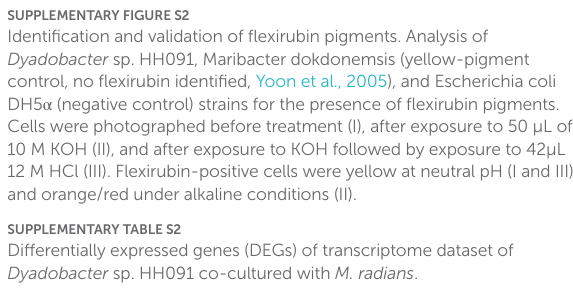
SUPPLEMENTARY TABLE S5 Differently expressed genes (DEGs) coding for the T9SS cargo